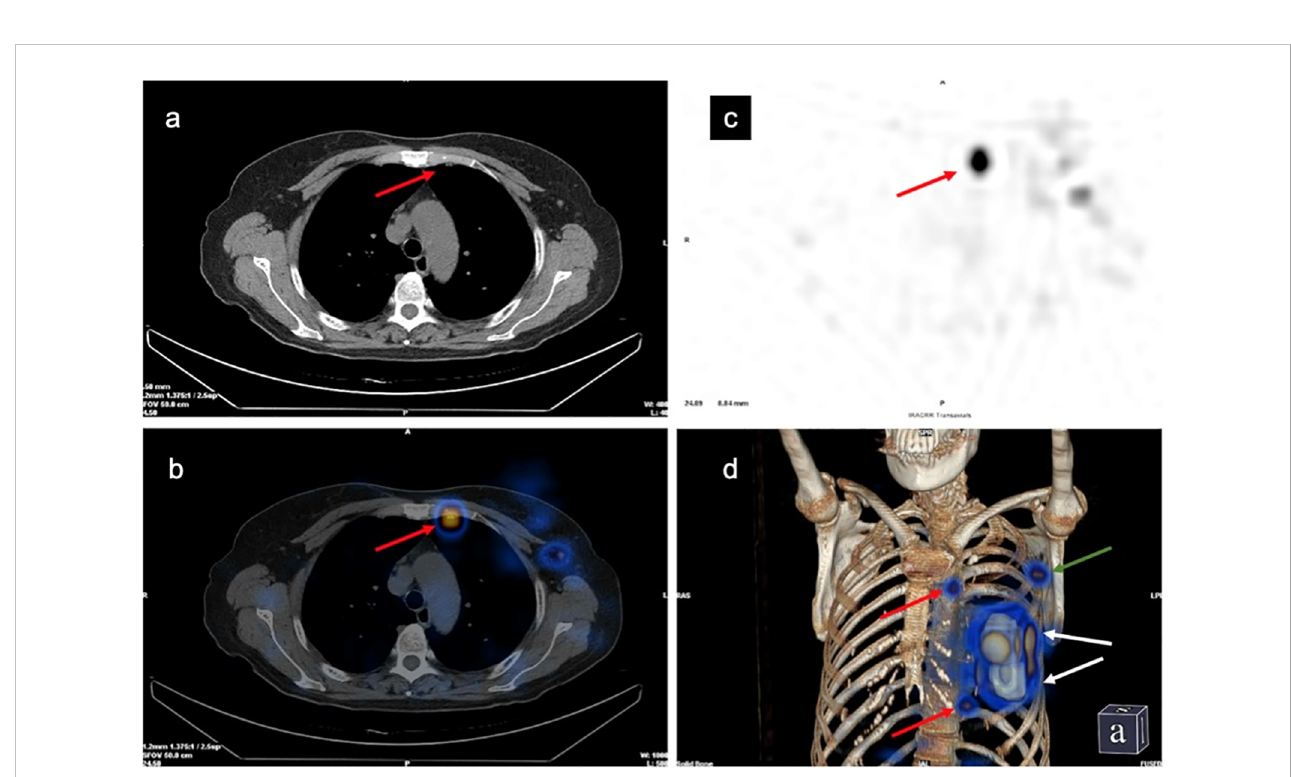
FIGURE 3 Development of the left internal mammary sentinel lymph nodes (IM-SLN) and left axillary sentinel lymph node (A-SLN). (A) Computed tomography (CT) plain scan. (B) Single-photon emission computed tomography imaging. (C) Tomographic fusion image. (D) 3D image. Red arrows, IM-SLNs; white arrows, injection points; green arrow,